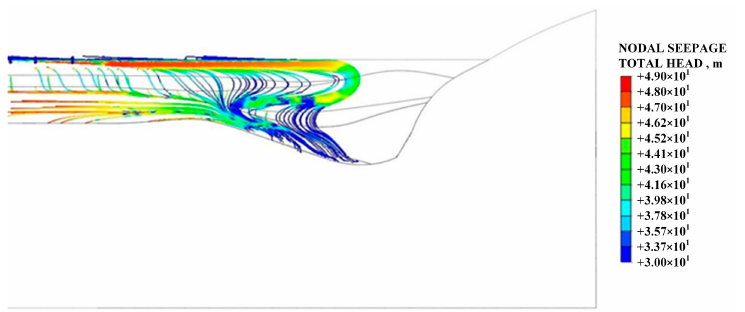
Figure 15. Settlement of the tunnel